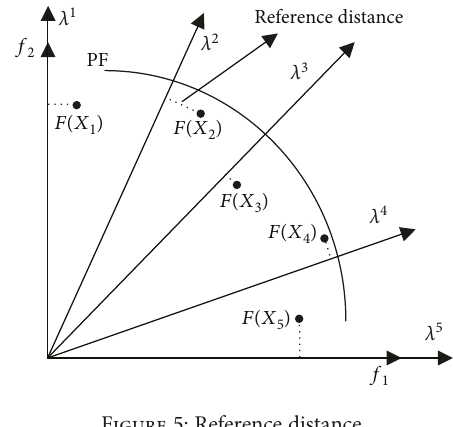
Figure 5: Reference distance.